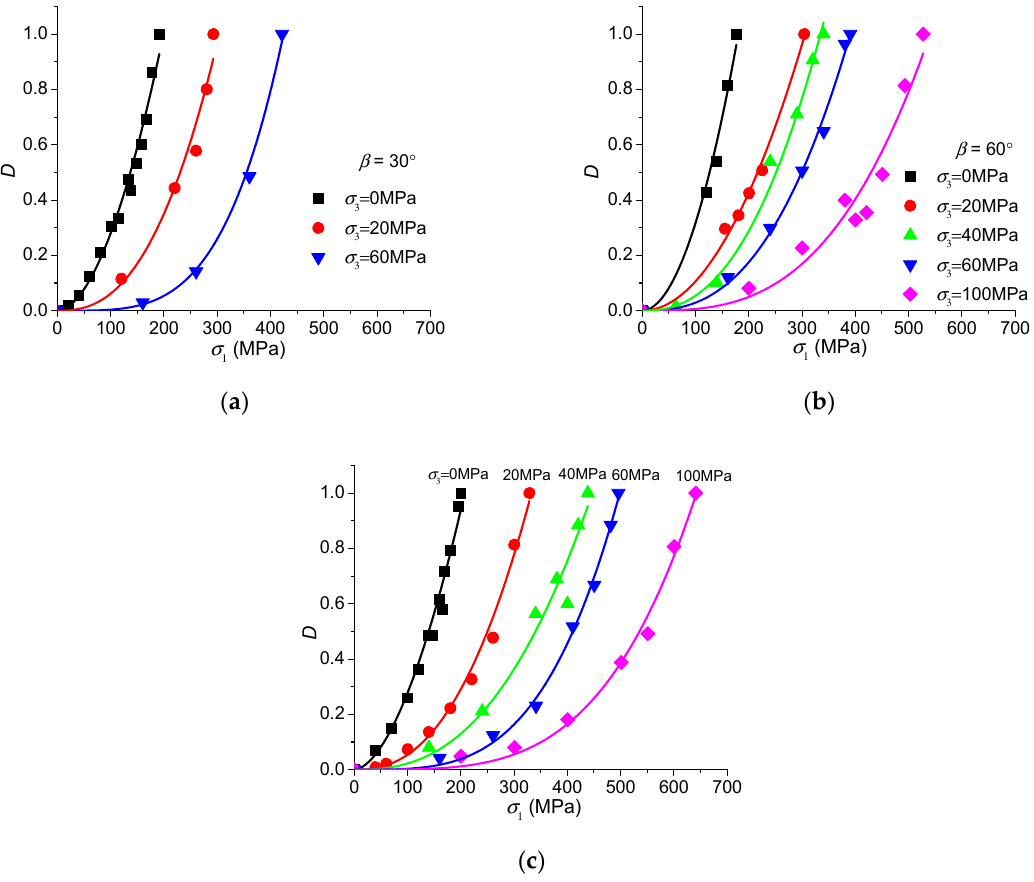
Figure 12. Evolution of damage variable with the increase of axial stress for the shale samples with different oriented weak planes (( a ) β = 30 ° , ( b ) β = 60 ° , and ( c ) β = 90 °) under various confining pressures. Table 3. Fitted constant parameters a and b in the damage evolution equation.